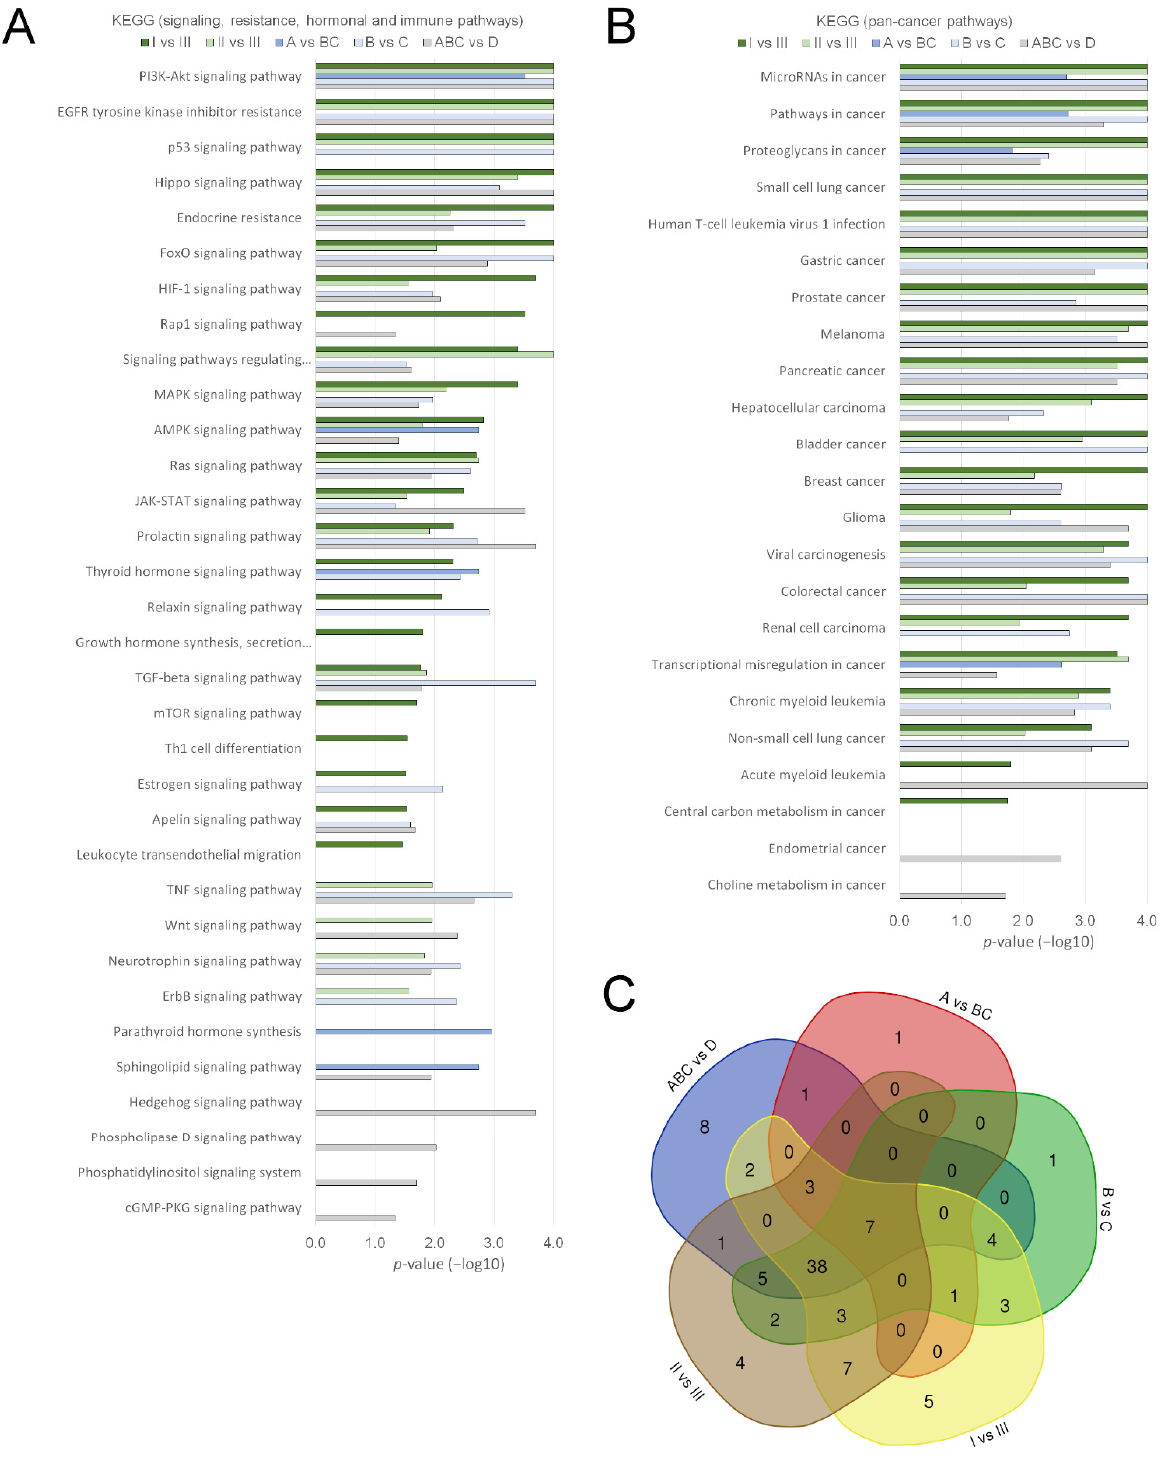
Figure 4. KEGG pathway analysis for differentially expressed miRNAs. The figure shows significant KEGG pathways for mRNAs targeted by the differential miRNAs from miRNAseq. ( A ) KEGG signalling, resistance, hormonal and immune pathways and ( B ) Pan-cancer associated pathways for comparison of prostate cancer (PCa) status and progression groups (A–C, I–III, n = 30 patients) and the healthy group (D, n = 10). ( C ) Venn diagram of all significant pathways for the comparisons. Differential miRNAs with FDR p or p < 0.05 were included in the analysis (Tables S5 and S10). Pathway p -values are shown in − log10